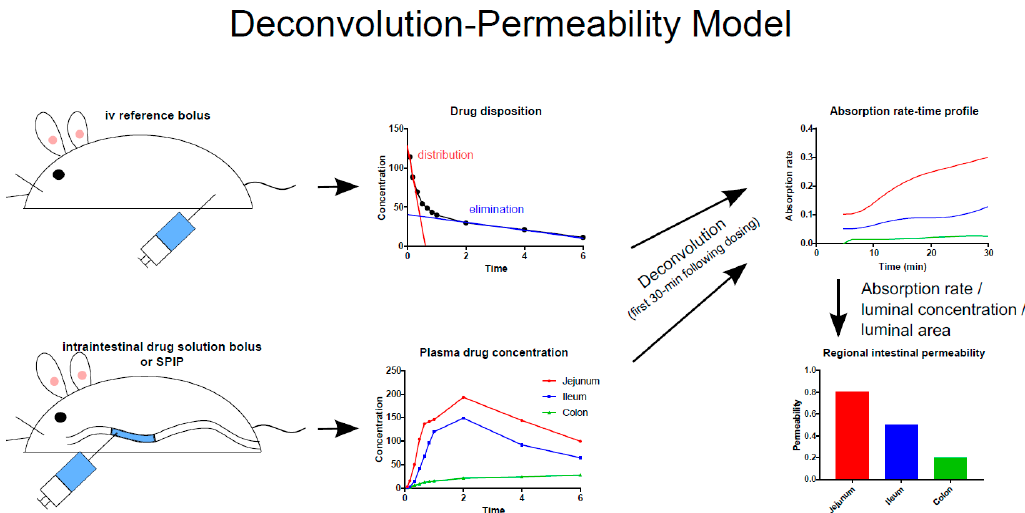
Figure 2. Schematic illustration of the deconvolution-permeability model, which can be used to determine the regional intestinal permeability of model drugs based on their appearance in the plasma following intravenous and intraintestinal administration of the drug in solution [36]. The method has been successfully applied to determination of intestinal permeability in rats, dogs, and humans [3,31,33,35,37,38]. SPIP = single-pass intestinal perfusion.